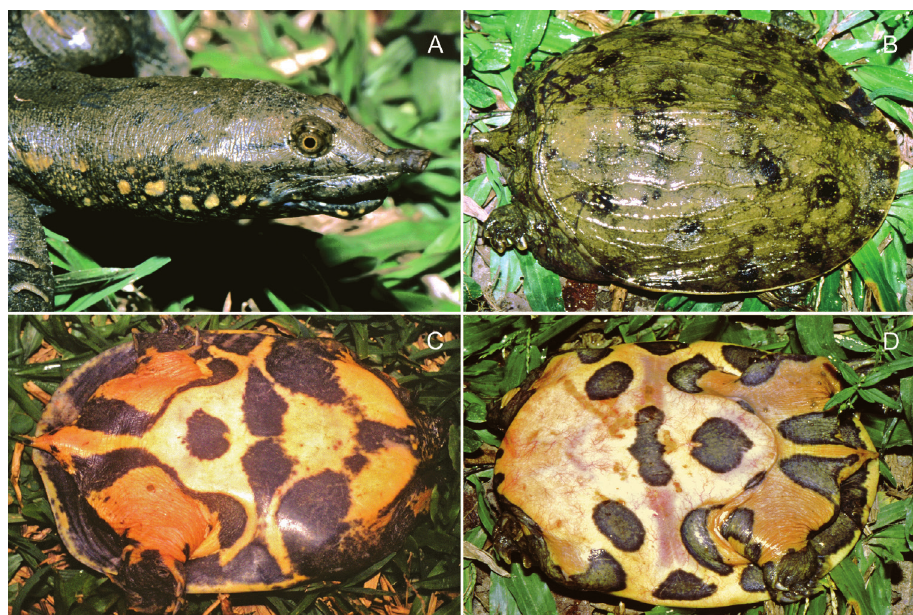
Figure 2. Two paratypes of Pelodiscus variegatus sp. n. in life. A, C MTD 44045, female, 75.2 mm PL B, D MTD 42834, female, 86.6 mm PL. Photographs Thomas Ziegler. Table 2. Selection of diagnostic sites of the cyt b gene for Pelodiscus species (94 wild-caught individu- als from Gong et al. 2018). Positions refer to the 1168-bp-long reference alignment in the Supporting Information. G, H, and I are genetic lineages that represent putatively distinct taxa (Gong et al. 2018). n 130 132 147 148 195 204 285 288 315 477 520 730 741 1081 P. variegatus sp. n.